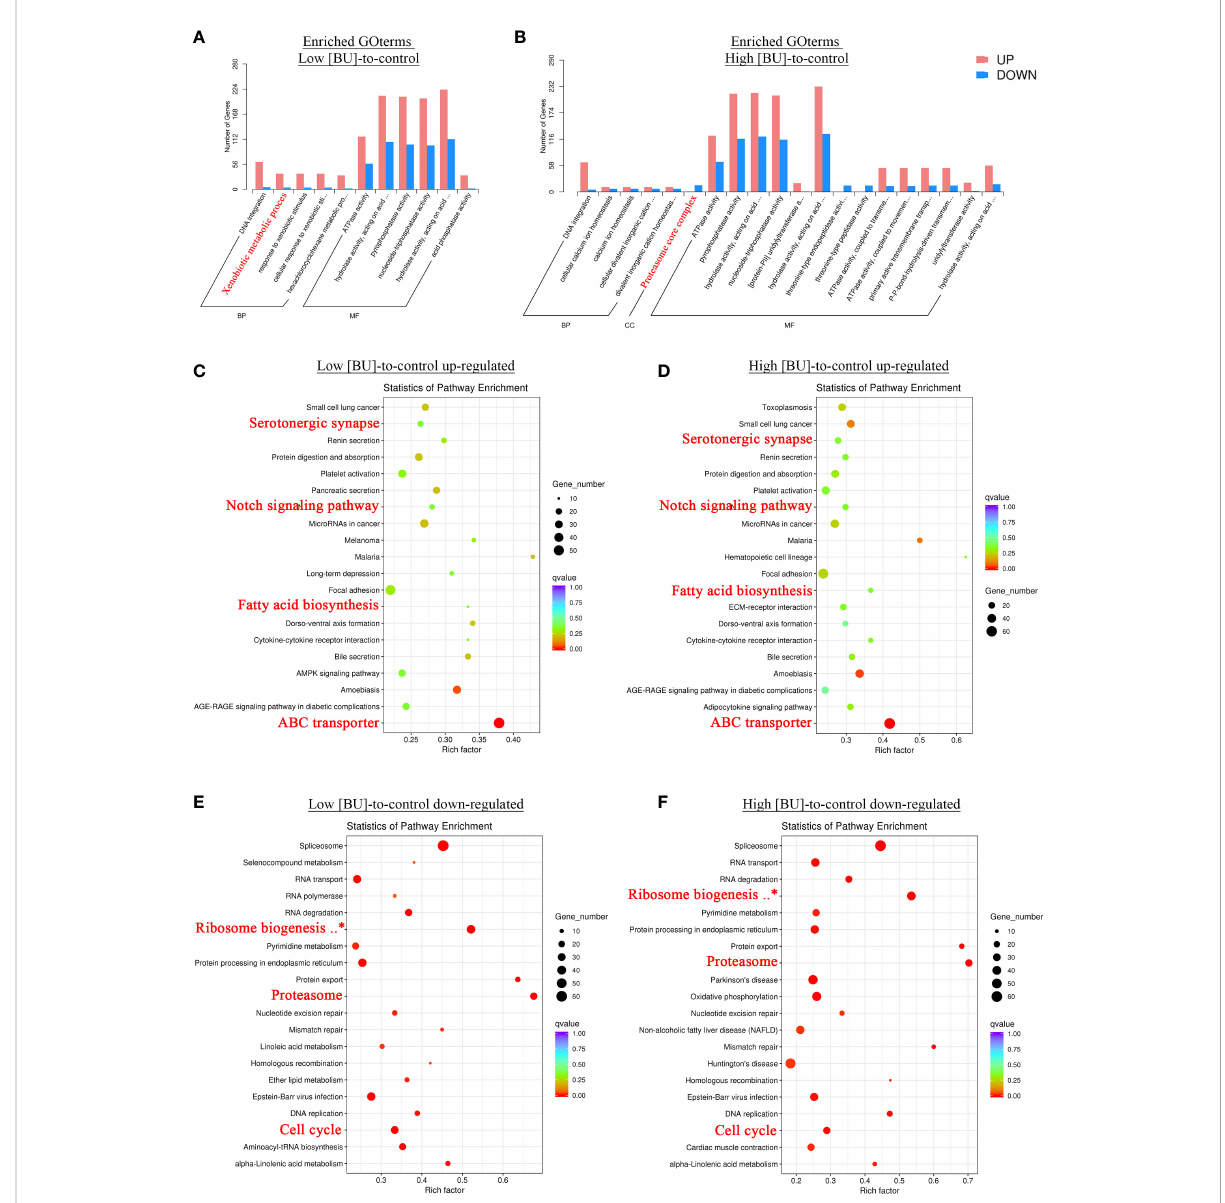
FIGURE 3 GO and KEGG enrichment analyses of differentially expressed genes in response to BU treatment. (A, B) Results of GO enrichment analysis. Enriched GO terms among the DEGs in (A) low concentration (5 m g mL -1 ) and (B) high concentration (10 m g mL -1 ) BU treatment were shown. (C – F) Results of KEGG enrichment analysis. The enrichment q-values of each enriched KEGG pathway among (C) up-regulated and (D) down- regulated DEGs in low concentration BU treatment, (E) up-regulated and (D) down-regulated DEGs in high concentration BU treatment were shown in the dot plots. Pathways that are not relating to human disease and broadly implicated across metazoan taxa were highlighted in